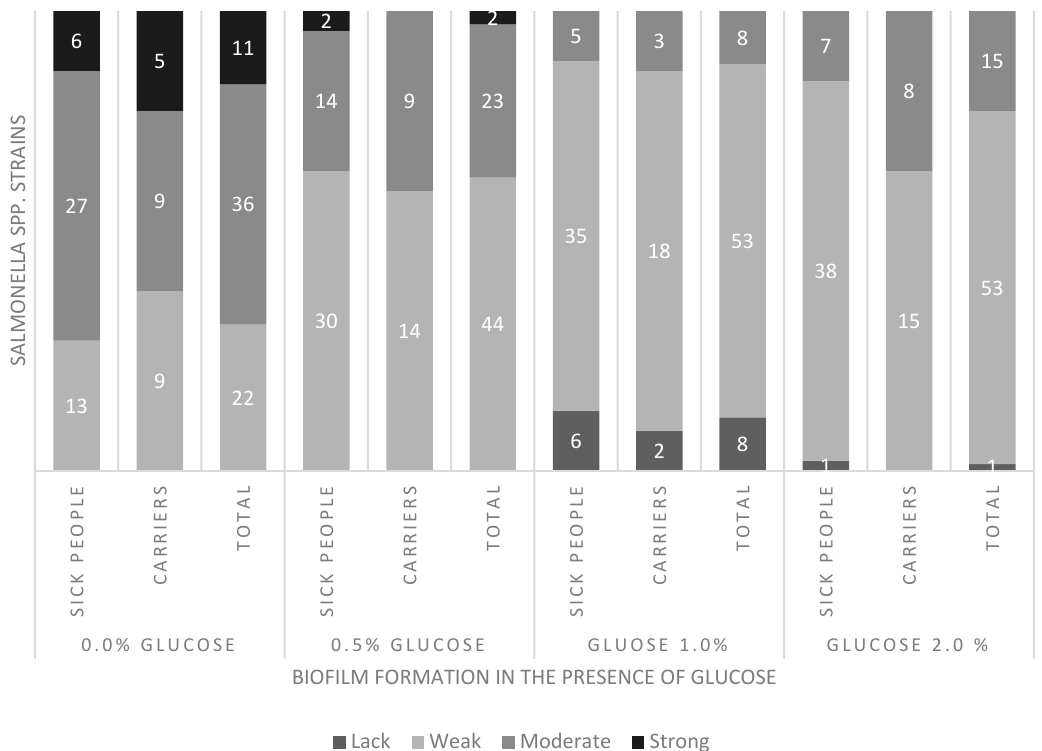
Figure 1. Biofilm of S. enterica strains ( n = 69) in various glucose concentrations. The mean absorbance value for the examined strains isolated from patients was the lowest in the TSB medium supplemented with 1.0% glucose (0.0360), and the highest in TSB without glucose (0.1184). An analogous tendency was observed for the strains isolated from carriers, whereas mean absorbance values stayed within the range 0.0362 to 0.1164 (Supplementary Figure S1). It was indicated that in relation to the control (TSB BD), adding glucose significantly ( p ≤ 0.05) reduced biofilm formation by S. enterica strains. Additionally, statistically significant differences ( p ≤ 0.05) were shown in absorbance values at glucose concentrations equal to 0.5% and 1.0%. It was recorded that after adding glucose, S. enterica strains isolated from carriers formed stronger biofilm than the strains isolated from patients, but the indicated differences were not statistically significant ( p > 0.05).